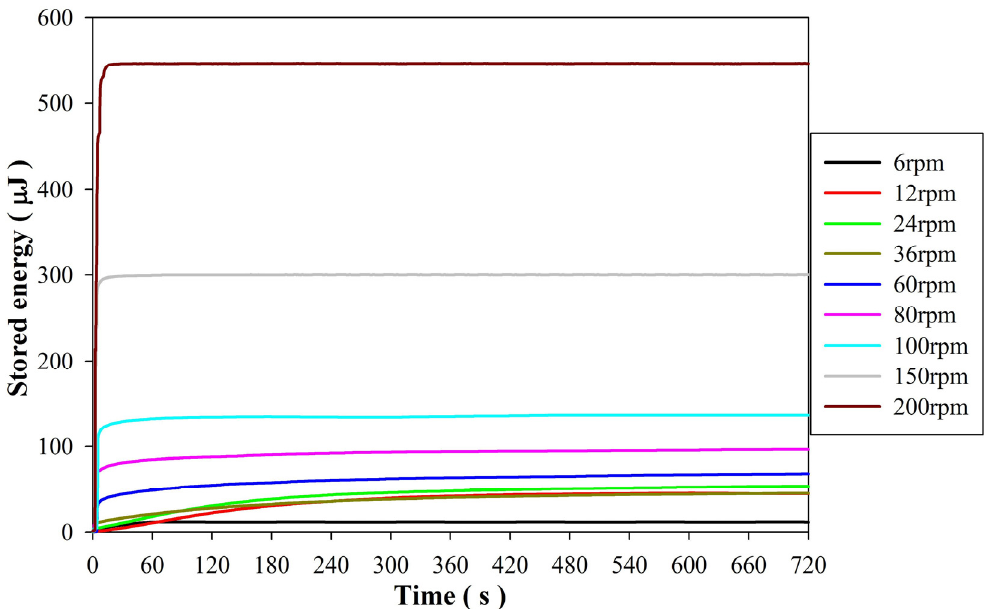
Figure 5. Stored energy in the 10 μ F storage capacitor from the disk generator under various rotational speeds.